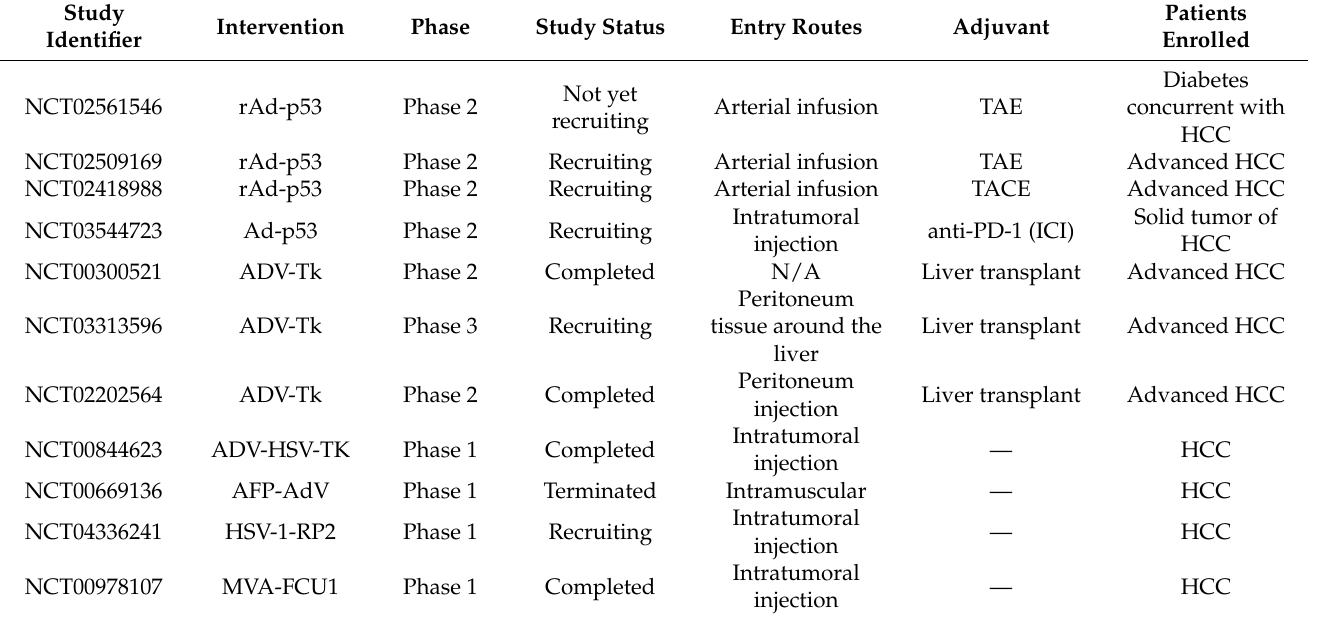
Table 1. Data from https://www.clinicaltrials.gov/ accessed on 10 May 2022 showing clinical trials viral vector mediated gene therapy for the treatment of advanced hepatocellular carcinoma.